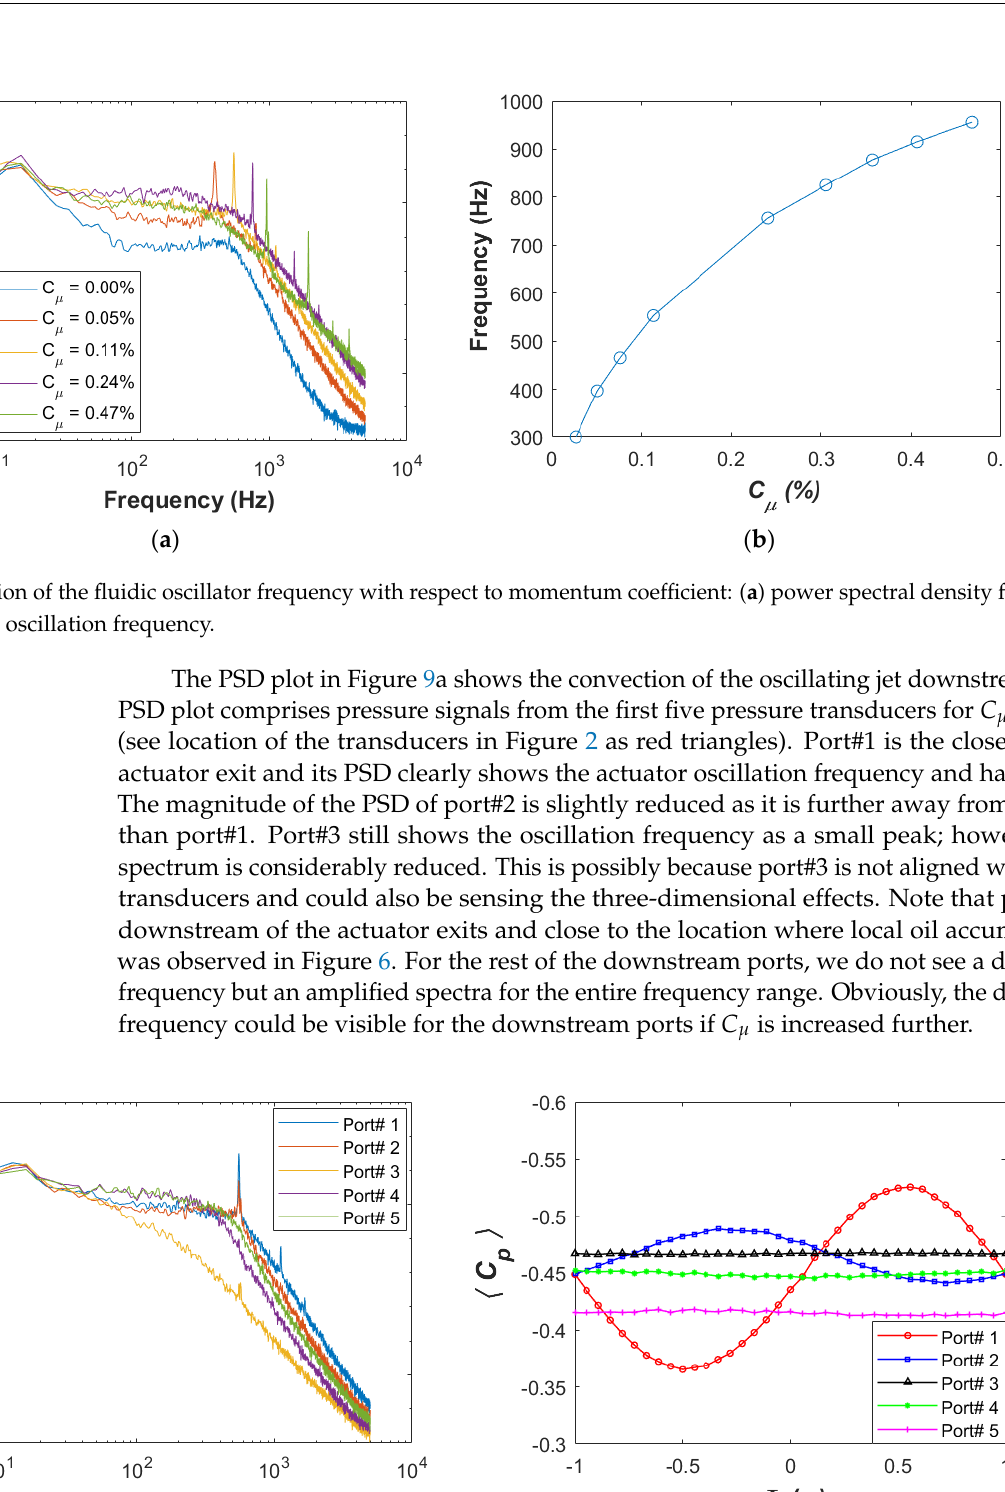
11 of 24 Figure 7. Surface oilflow visualization for the fluidic oscillator flow control case with C µ = 0.24%. 3.2.2. Unsteady Pressure Measurements The jet emitting from the fluidic oscillators oscillates at a specific frequency that depends on the actuator geometry and the mass flow through. A typical power spectral density (PSD) of an oscillating jet is shown in Figure 8a. The pressure signal of the fluidic oscillator jet was acquired from the unsteady pressure transducer that is close to the ac- tuator exit (port#1, see Figure 2). As shown in this figure, PSD of the baseline pressure signal does not show a preferred or shedding frequency associated with the separation bubble similar to the previous studies [1,14]. Compared to the baseline case, the fluidic oscillators amplify the spectrum for most of the frequencies. Different momentum coef-